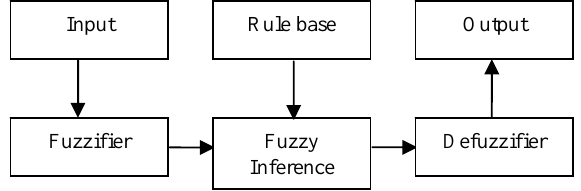
Fig. 3. Schematic representation of Mamdani